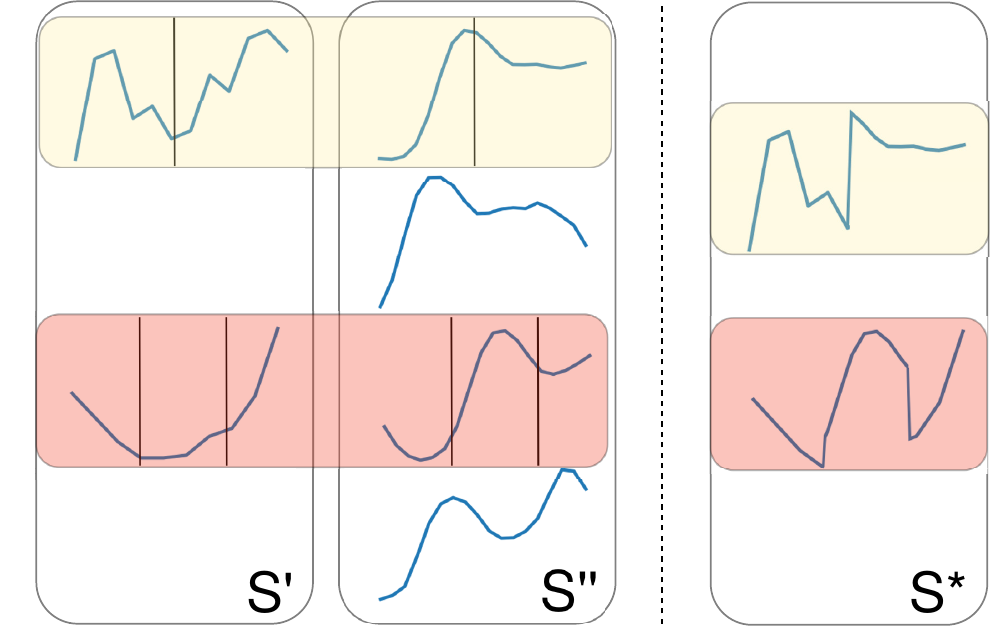
Figure 4. An example of one- and two-point crossover applied on individual